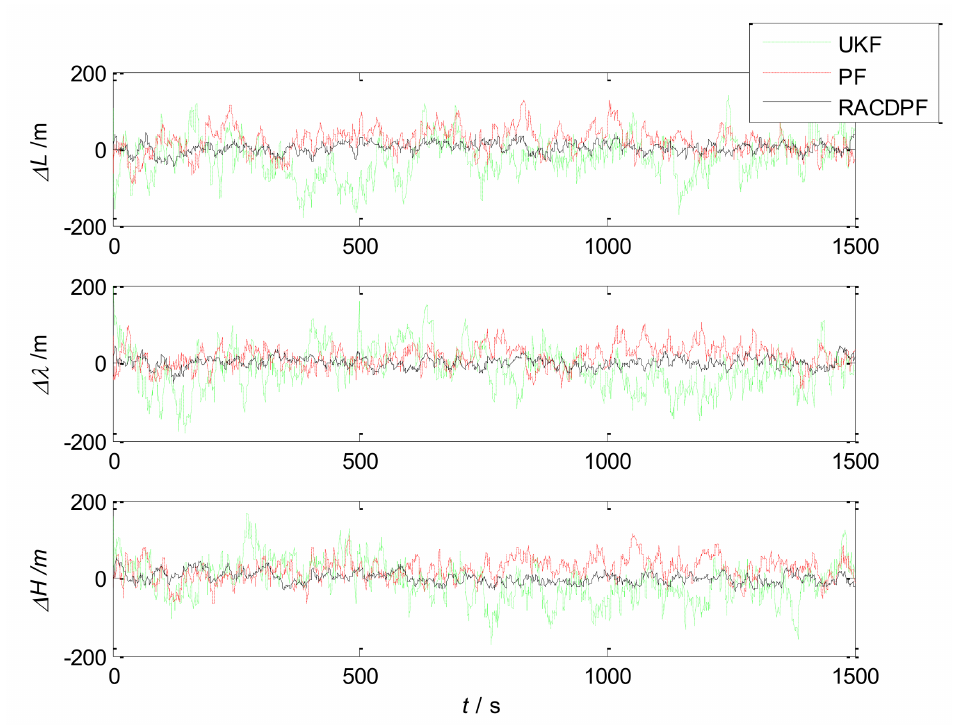
Figure 9. Position errors of the three filtering algorithms ( M =